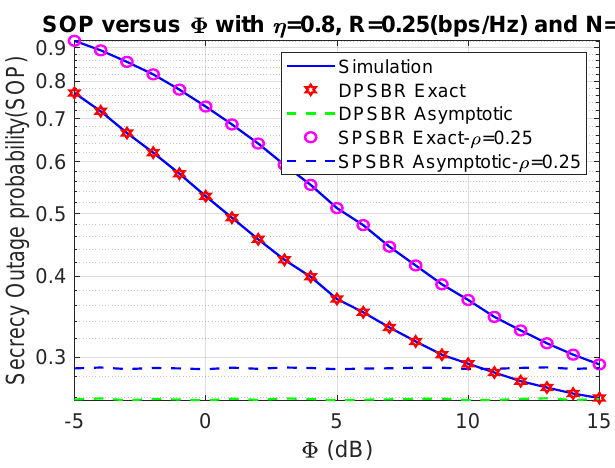
Figure 3. Outage probability versus Φ